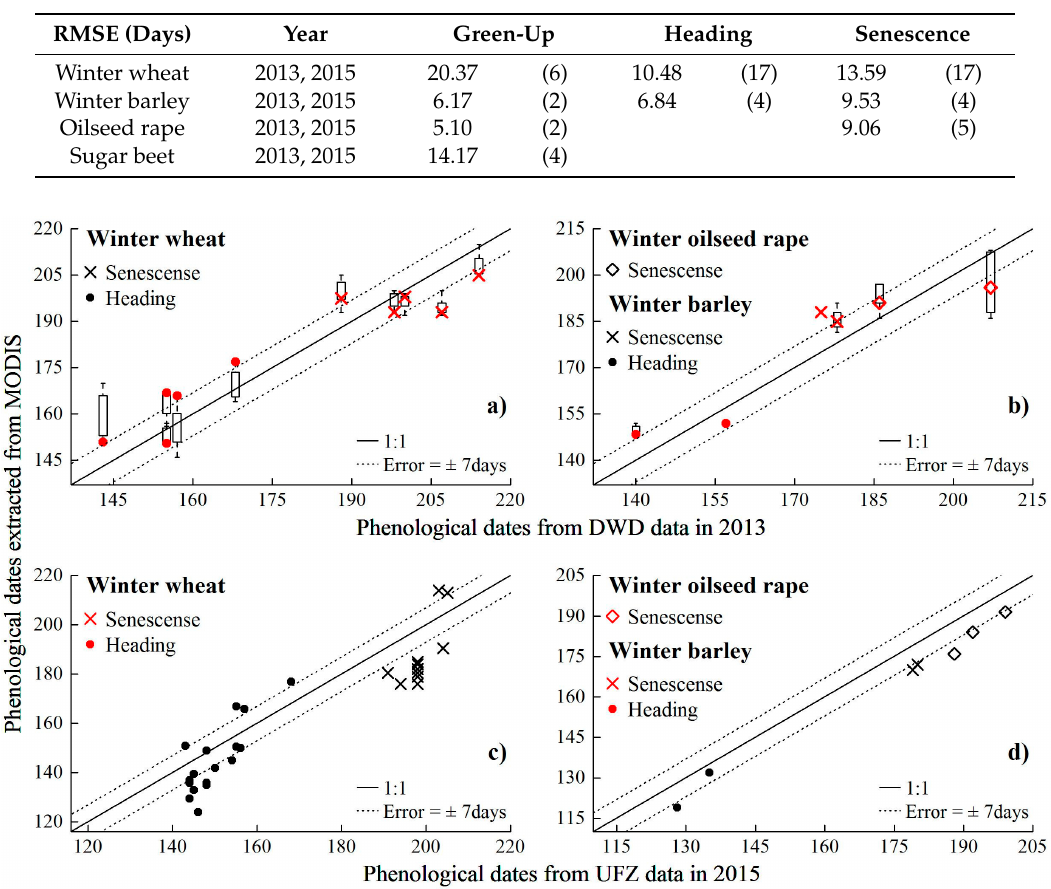
Figure 6. Validated satellite-derived phenological dates for different crops in: ( a , b ) 2013 versus DWD data; ( c , d ) 2015 versus UFZ data. Red-coloured symbols indicate fields which were closest to DWD stations. Each box represents phenostages of all fields which were within 3 km around one DWD station.